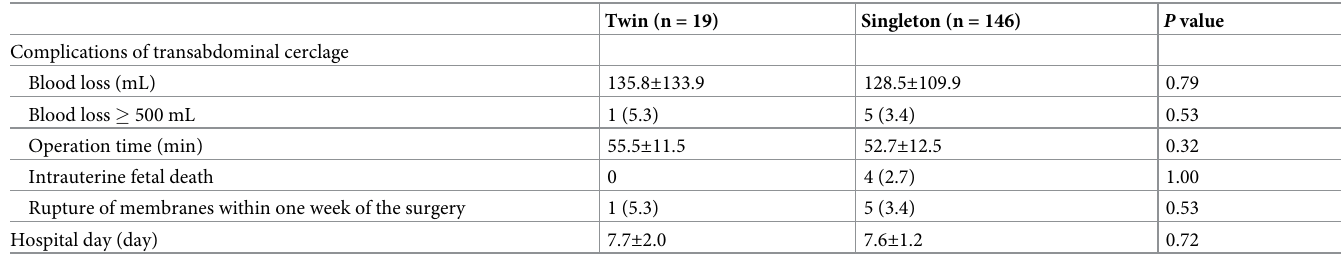
Table 5. Complications of transabdominal cerclage.